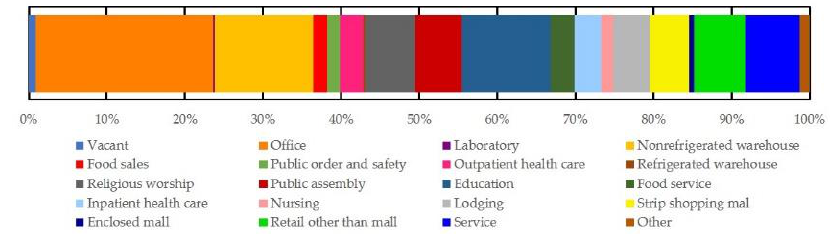
Figure 1. Frequency distribution of commercial building use types in the dataset.